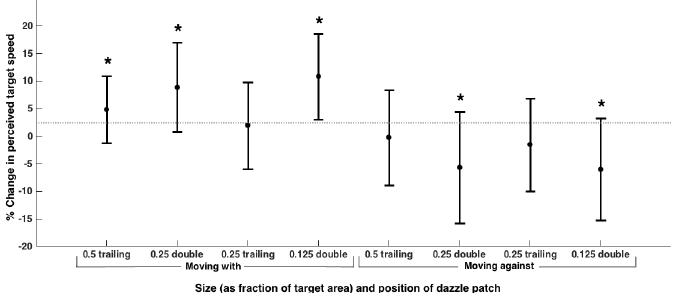
Fig 5. Mean ( ± SD) percentage change in perceived speed for Experiment 4 (N = 15 participants). Dynamic texture was present only at the trailing edge of the target or at both ends ( ‘ double ’ ). * Indicates change in perceived speed is significantly different from zero. The effect on perceived speed was greatest for conditions where there was a patch of dynamic texture at each end ( ‘ double ’ ), even when the texture at the trailing edge covered an identical proportion of the